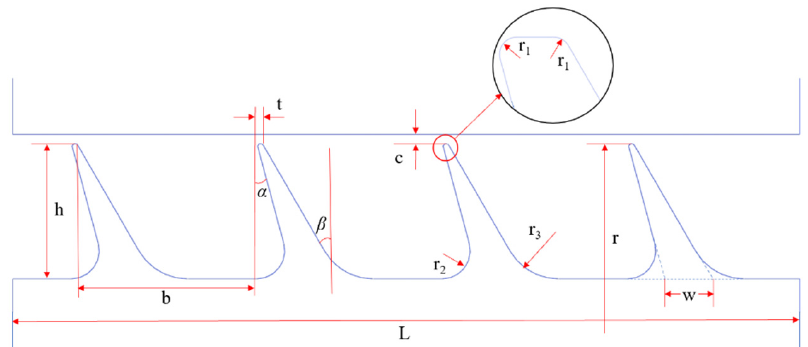
Figure 1. Geometric parameter model of labyrinth seal.